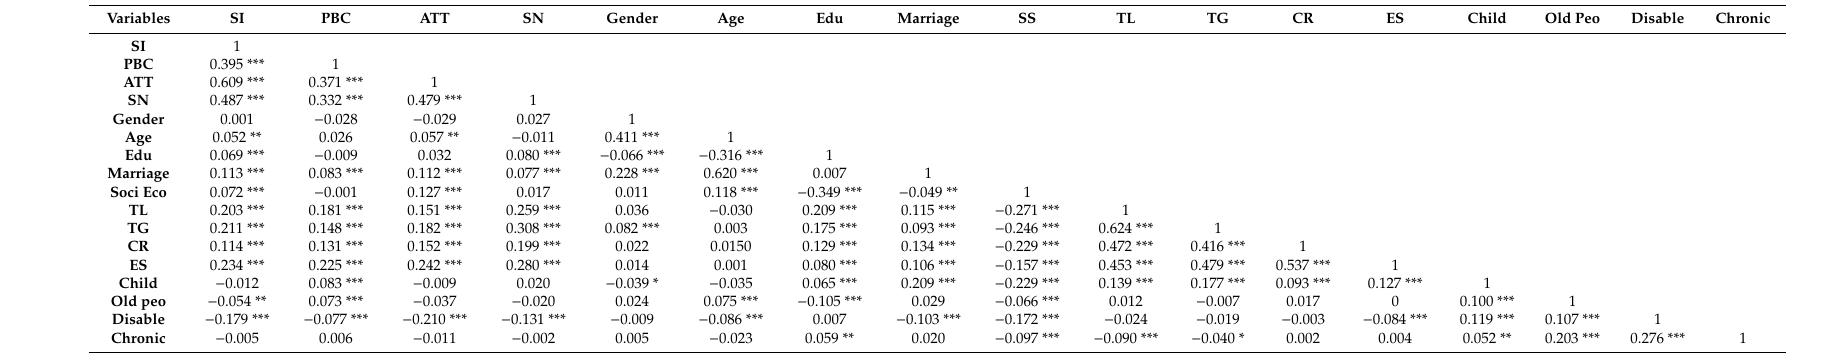
Table 3. Correlation matrix of the studied